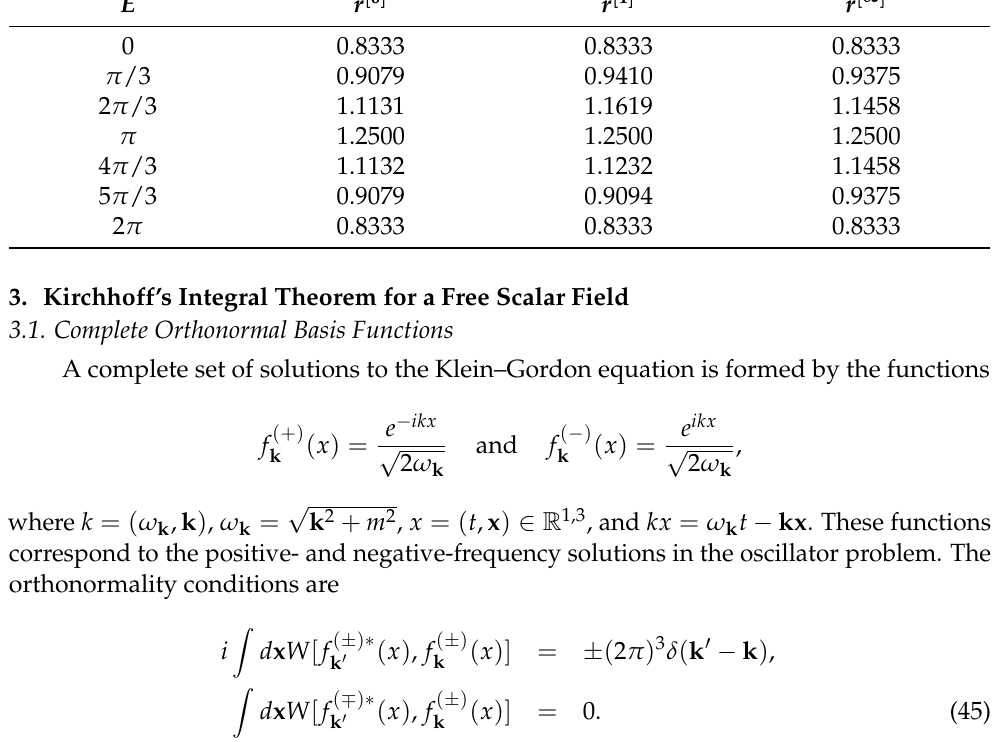
Table 2. First two iterations r [ l ] for the approximate solution of the radial equation of motion as compared to the exact solution r = r [ ∞ ] for seven values of E ∈ [ 0,2 π ] . E r [ 0 ] r [ 1 ] r [ ∞